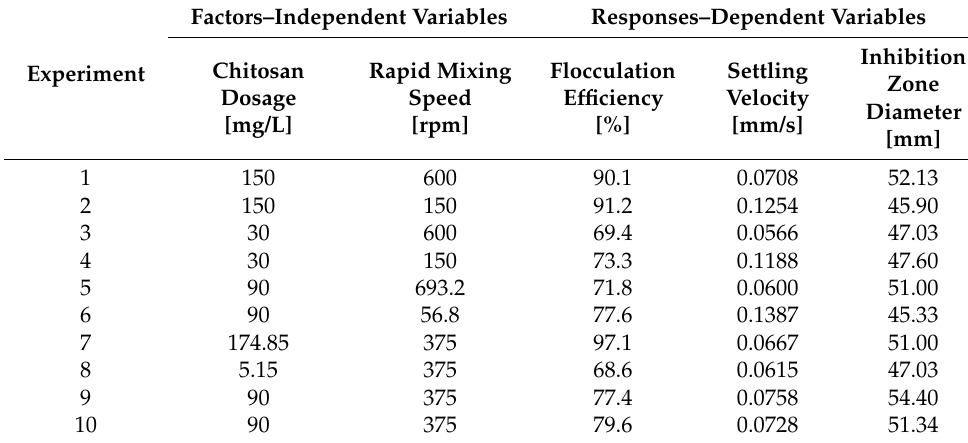
Table 1. Experimental design and responses for cheese whey effluent.